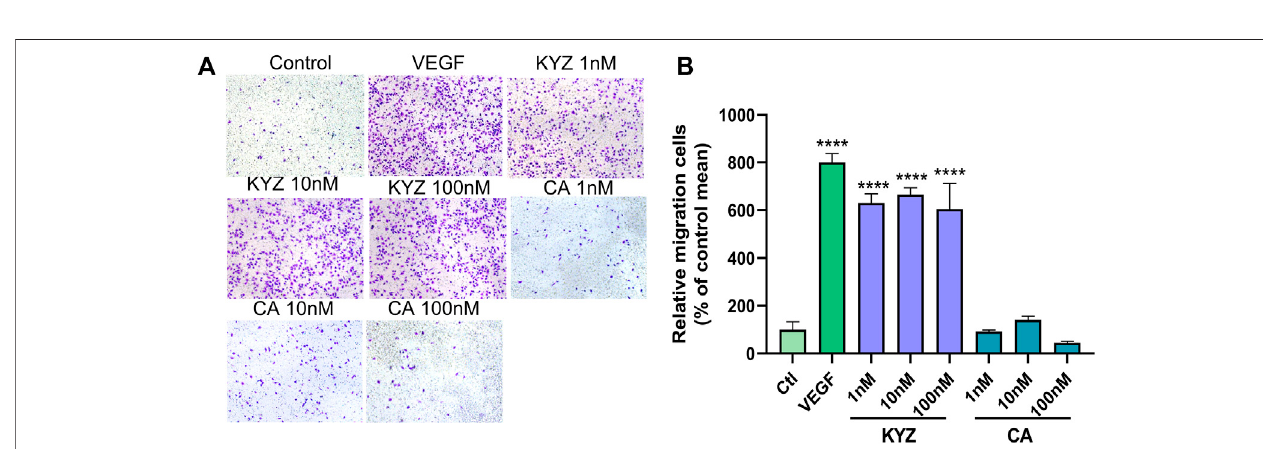
FIGURE6| TheKYZ treatment enhanced themigrationofHUVECs. (A) Thestainedcellscrossed thepolycarbonatemembrane bytreatmentwithKYZand CAfor 24 h.TheVEGF(20 ng/ml)wasusedasapositivecontrol.Thephotomicrographswereshownat×10magni fi cation. (B) Statisticalresultsofcellmigrationineachgroup. Theresultswereexpressedasapercentageofthemeantothecontrolgroup(mean±SEM).Statisticalanalysiswasperformedusingaone-wayanalysisofvariance, n = 3. ** p < 0.01,**** p < 0.0001 vs. control.